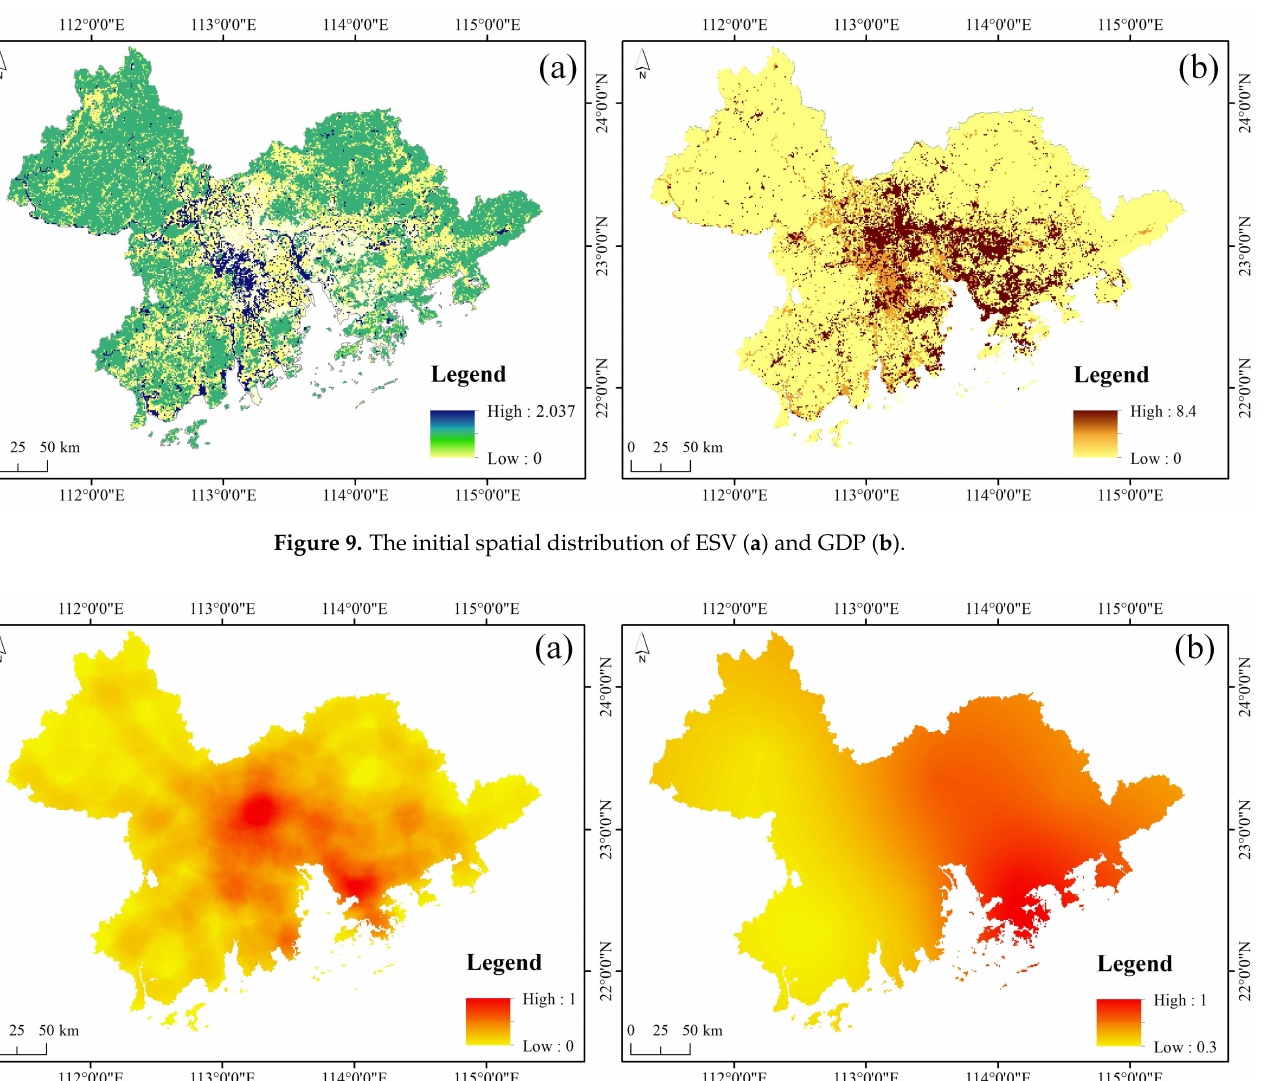
Figure 10. The spatial distribution of normalized accessibility ( a ) and ELI ( b ).